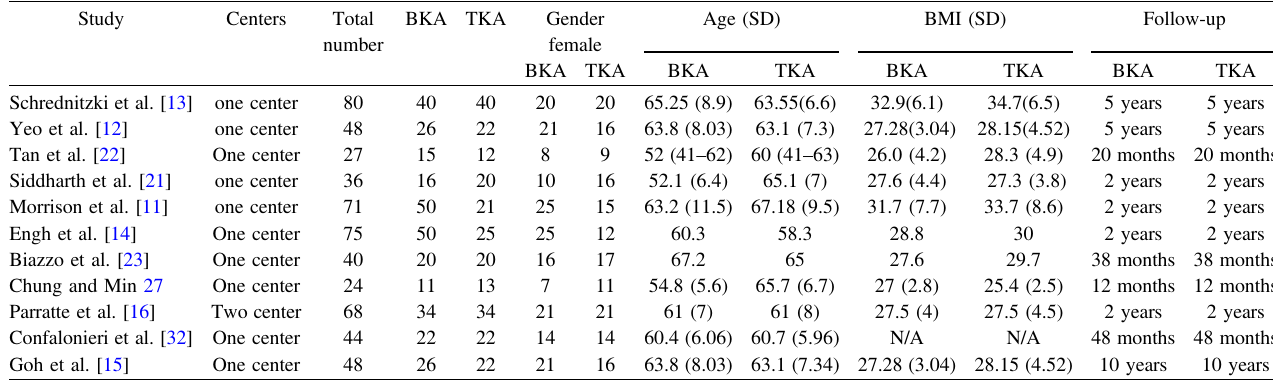
Table 3. Patient ’ s demographics.